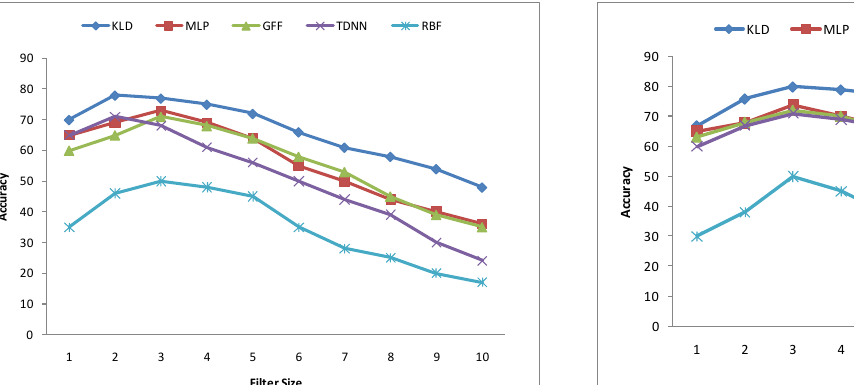
Fig. 6. Sensitivity analysis for data set parameters using KABO